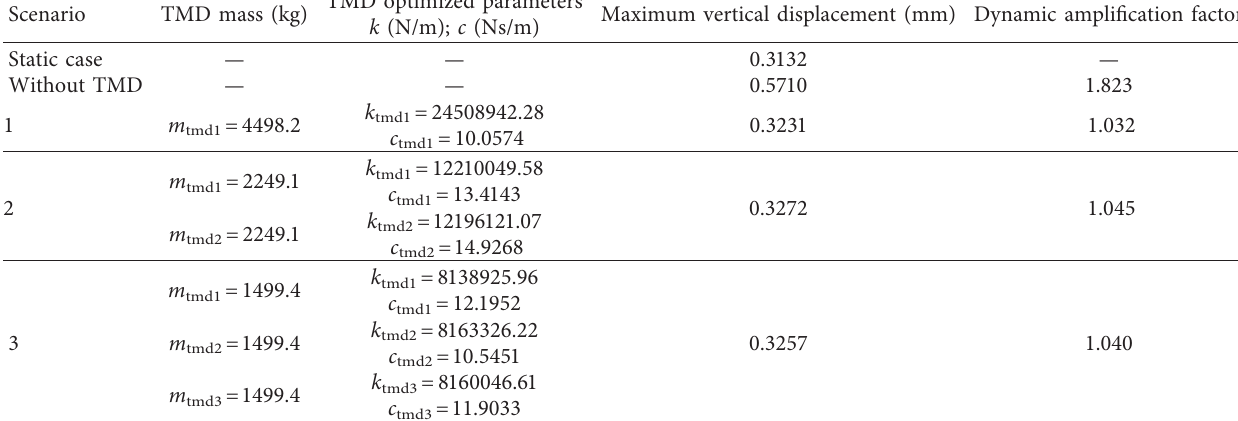
Table 2: Results of the proposed optimization procedure.